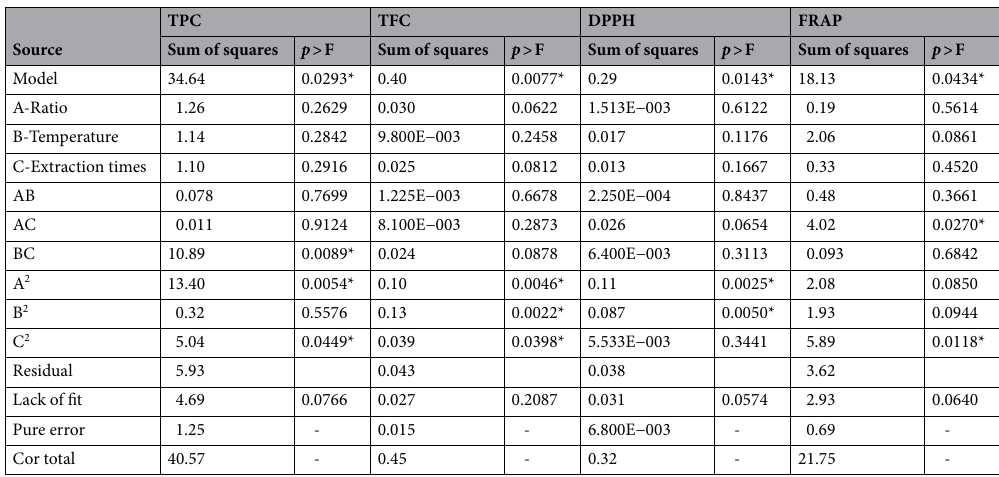
Table 4. Analysis of variance for the independent variables studied in the extraction of Roselle by the experimental